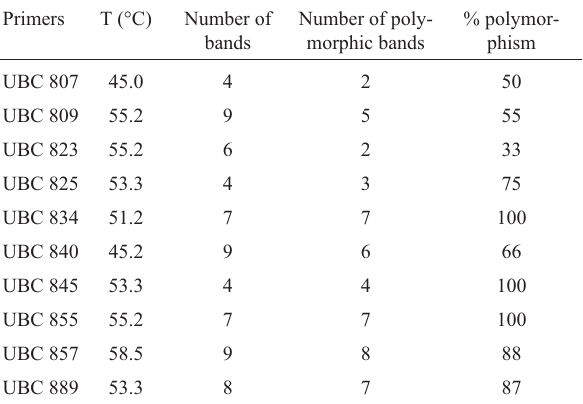
Table 2 - Data on the primers used to amplify total DNA of A. robusta . T = annealing temperature. Primers T (°C) Number of Number of poly- morphic bands